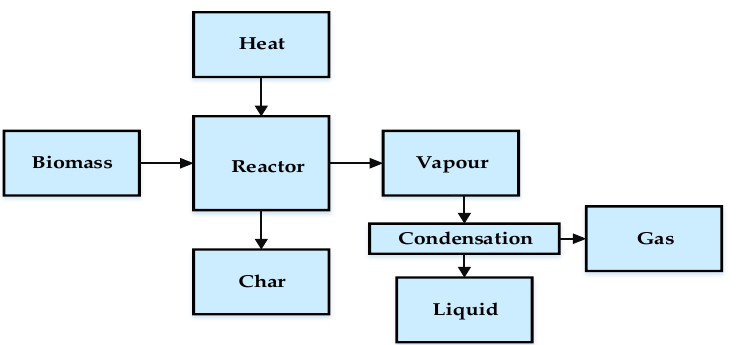
Figure 16. Reaction pathway of pyrolysis process.